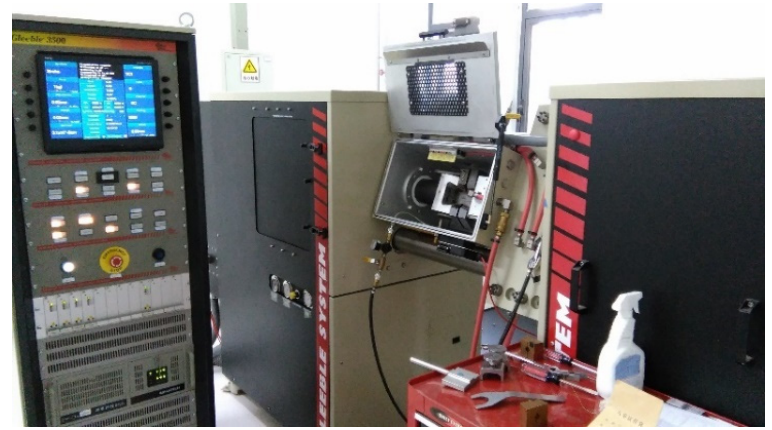
Figure 3. The thermomechanical compressor equipment.